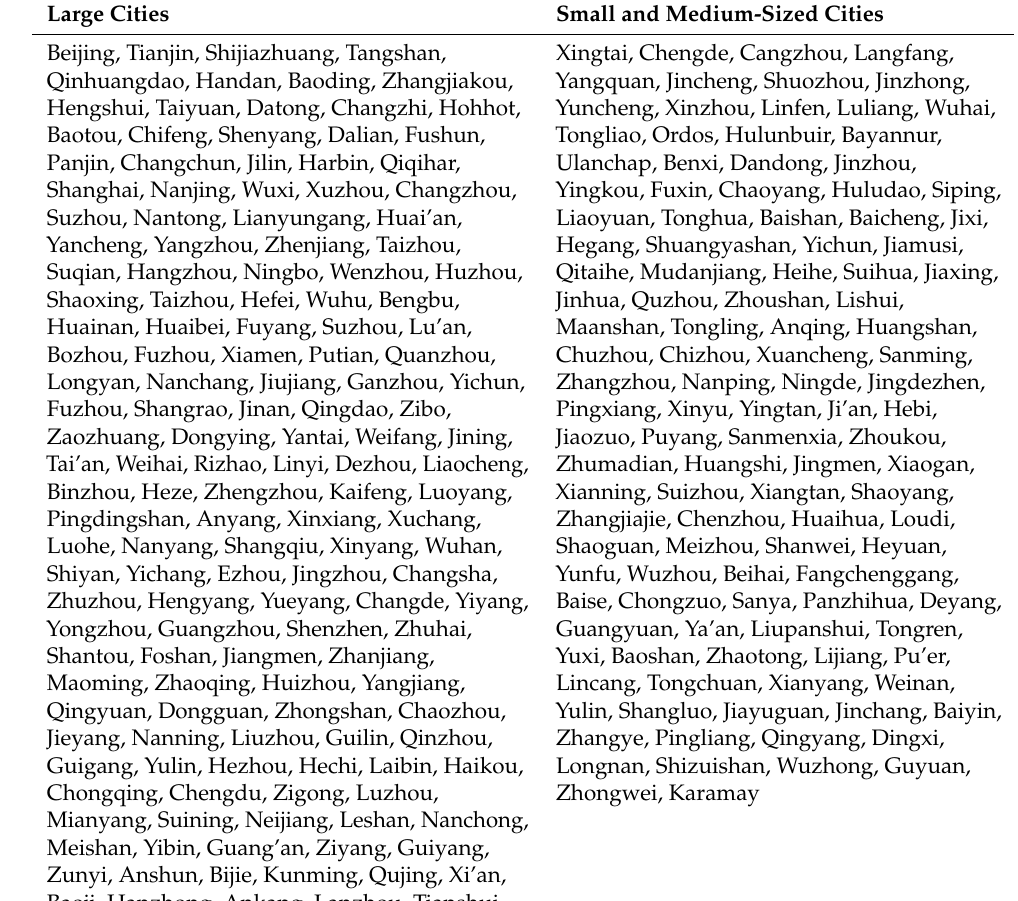
Table 7. Specific classification of cities.